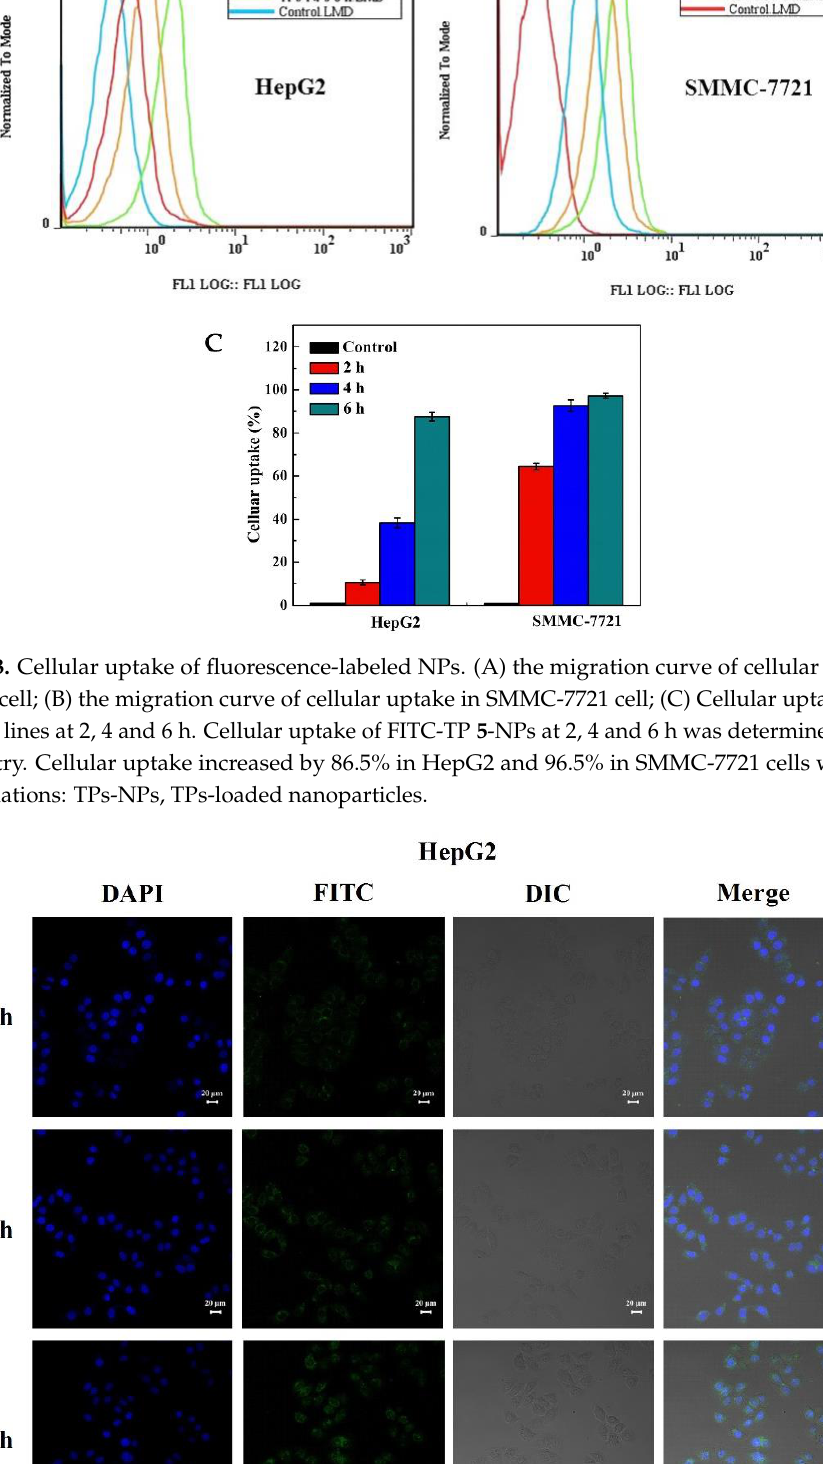
Figure 4. CLSM images of HepG2 and SMMC-7721 cells after incubation with FITC-TP 5 -NPs for 1, 2 and 4 h. Abbreviations: CLSM, confocal laser scanning microscopy; DAPI, 4′,6-diamidino-2- phenylindole; FITC, Fluorescein isothiocyanate. 2.5. Drug Release Kinetics of TP 5 -NPs Figure 5 shows the release profiles of free TP 5 and TP 5 -NPs in vitro. Free TP 5 suspension was released ~20% due to low solubility in PBS over 120 h. TP 5 showed quick release from TP 5 -NPs